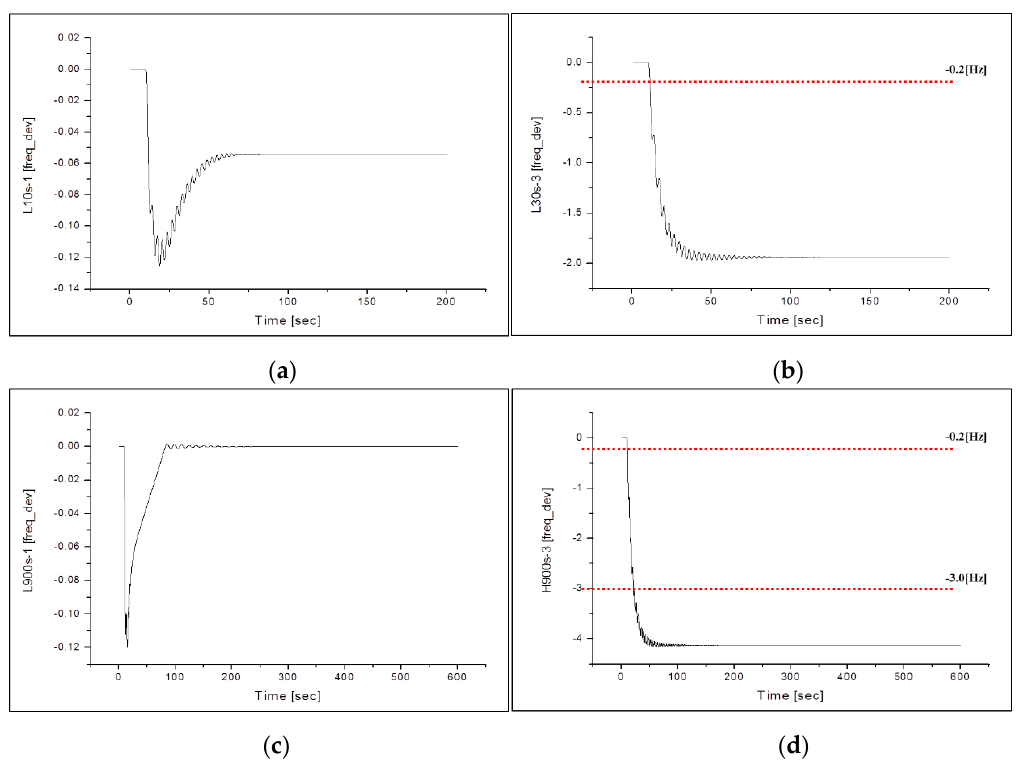
Figure 13. Frequency deviation of the load fluctuation (steel company group, summer): ( a ) GF response characteristics (light load 10 s-1 σ ); ( b ) GF response characteristics (light load 30 s-3 σ ); ( c ) AGC response characteristics (light load 900 s-1 σ ); ( d ) AGC response characteristics (heavy load 900 s-3 σ ).